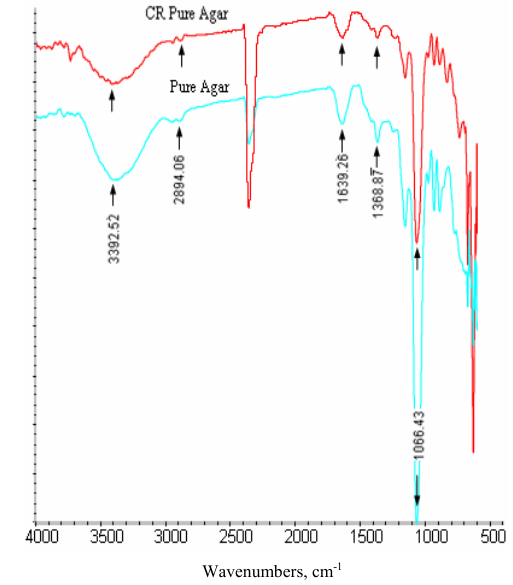
Figure 3. FTIR-ATR spectra of pure agar film and its crosslinked